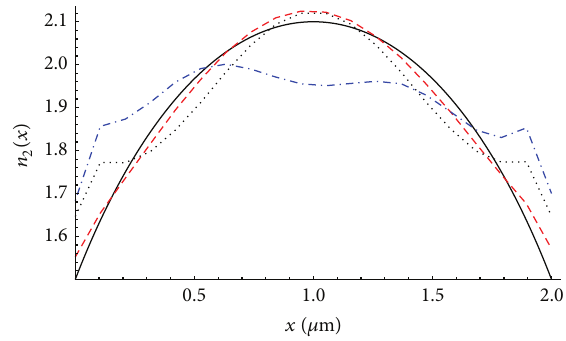
Figure 3: Reconstructed profiles. The solid curve corresponds to the initial profile 𝑛 2 . The red dashed line corresponds to the reconstructed profile at frequencies 23–25 THz, the dotted line cor- responds to 50–52 THz, and the blue dash-dotted line corresponds to 70–72 THz.